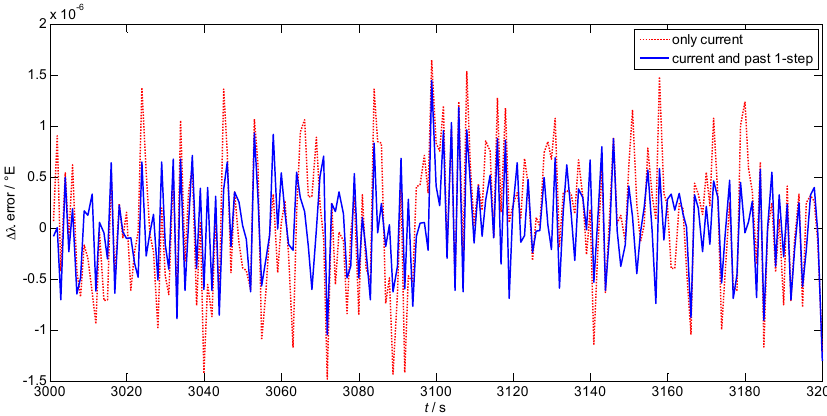
Figure 8. Prediction error of the position increment in longitude using different steps.